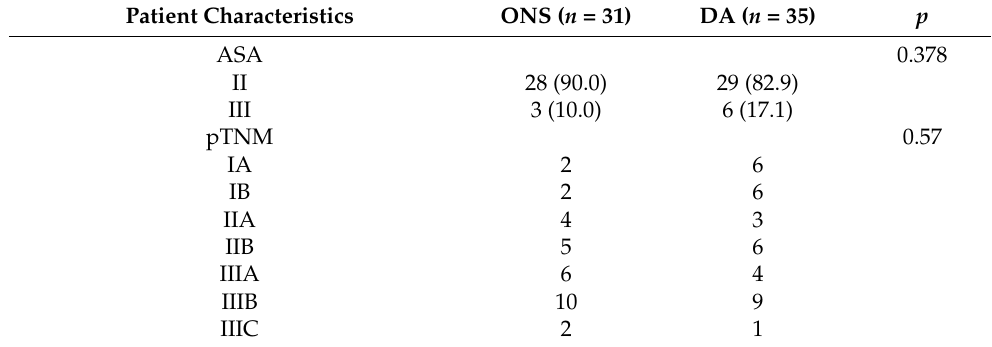
Table 1. Cont . Patient